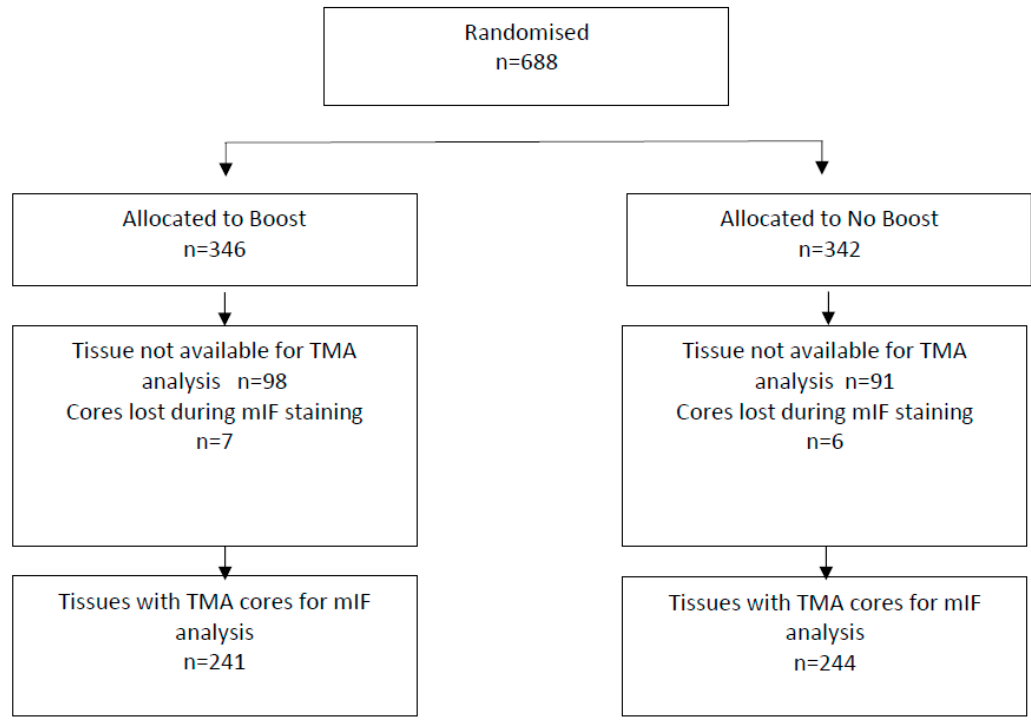
Figure 1. CONSORT flow diagram. The trial recruited from three main centres (St George, Wollongong and Liverpool Hospitals). Although the total number of patients assessed for eligibility and excluded for all centres is not known, these data are available for the main recruiting centre at St George Hospital, which contributed the majority of patients participating in the trial n = 546.